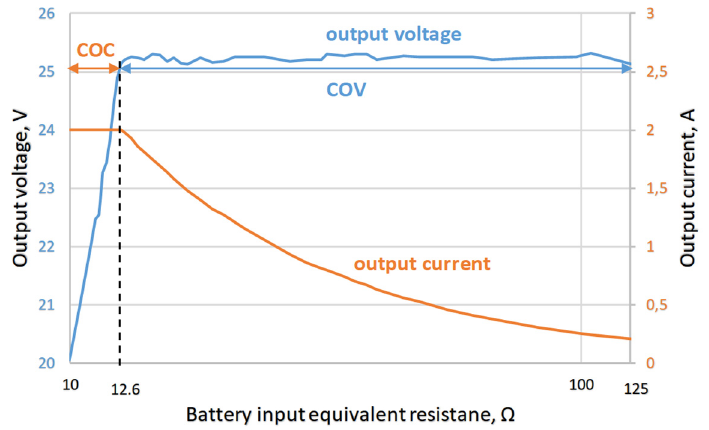
Figure 6. The charging current and voltage profiles (obtained from the measurements).